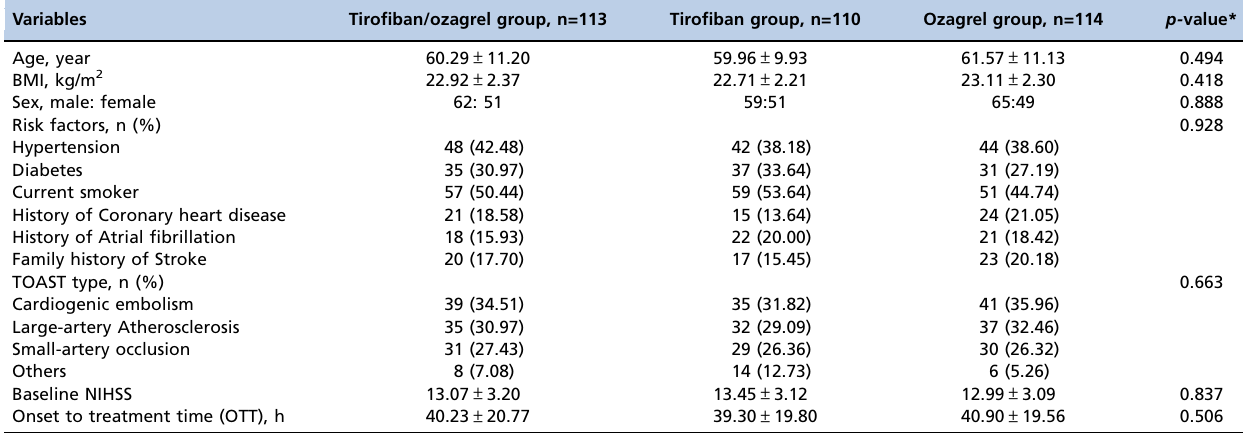
Table 1 - Demographic and baseline characteristics of the total study cohort. Variables